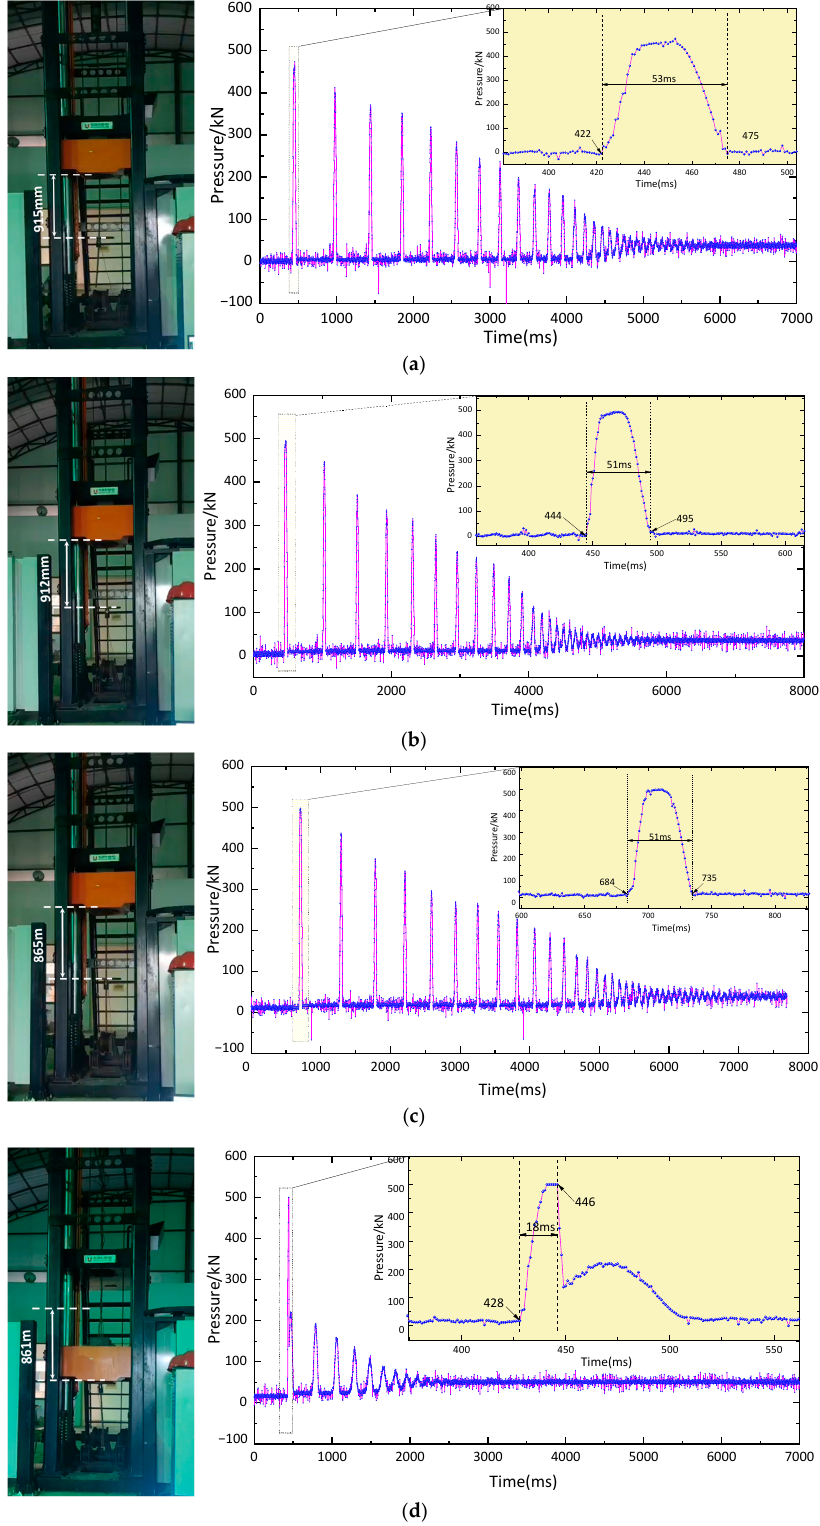
Figure 8. Impact process of Ф 21.6 mm cable: ( a ) Ф 21.6 mm first impact process; ( b ) Ф 21.6 mm second impact process; ( c ) Ф 21.6 mm third impact process; ( d ) Ф 21.6 mm fourth impact process. The cable of Ф 21.8 mm had a tensile strength of 1860 MPa, and withstood five shocks. The total impact resistance energy was about 9.9 × 10 4 J and the total extension was 68 mm. The hammer impact process is shown in Figure 9a–e. The average duration of the first four impact processes was 45.5 ms and each impact duration was roughly the same. The aver- age impact energy was 19,666.15 J and the average force was 231.7 kN. The impact pressure in the stable stage was about 500 kN. The cable still had the strength strengthening effect under the impact force.